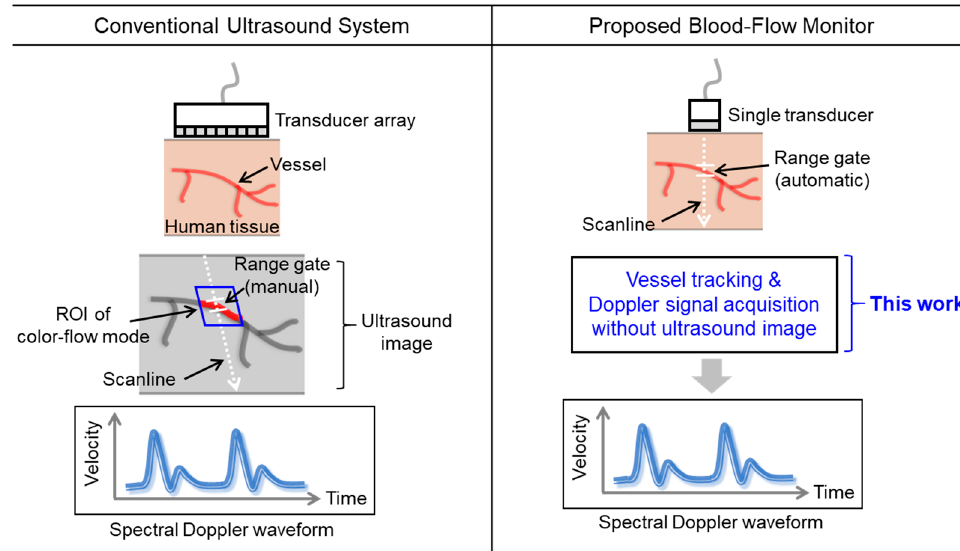
Figure 1. Features of this work compared to conventional medical ultrasound system; ROI: region of interest.